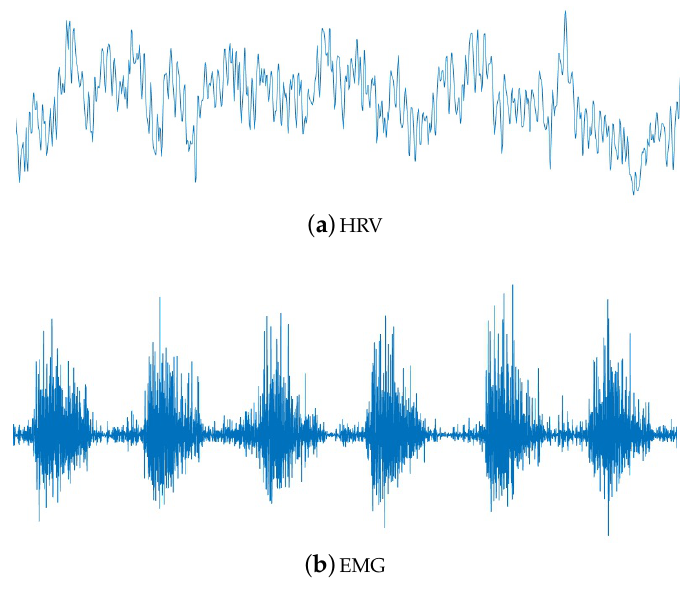
Figure 4. The patterns of HRV and